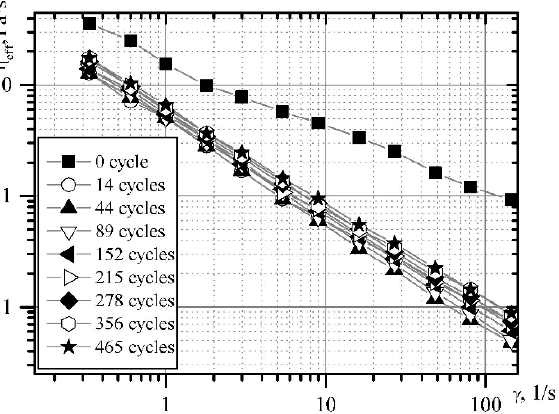
Figure 13. The dependence curve of the effective viscosity for the “Yagidka” product during the treatment in an emulsifier at a temperature of 10 °C.